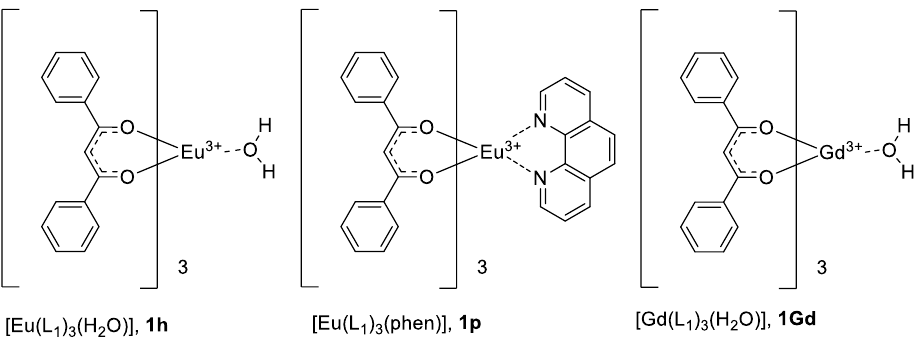
Figure 1. Known complexes of Eu(III) and Gd(III) with dibenzoylmethane and ancillary ligands. Due to the